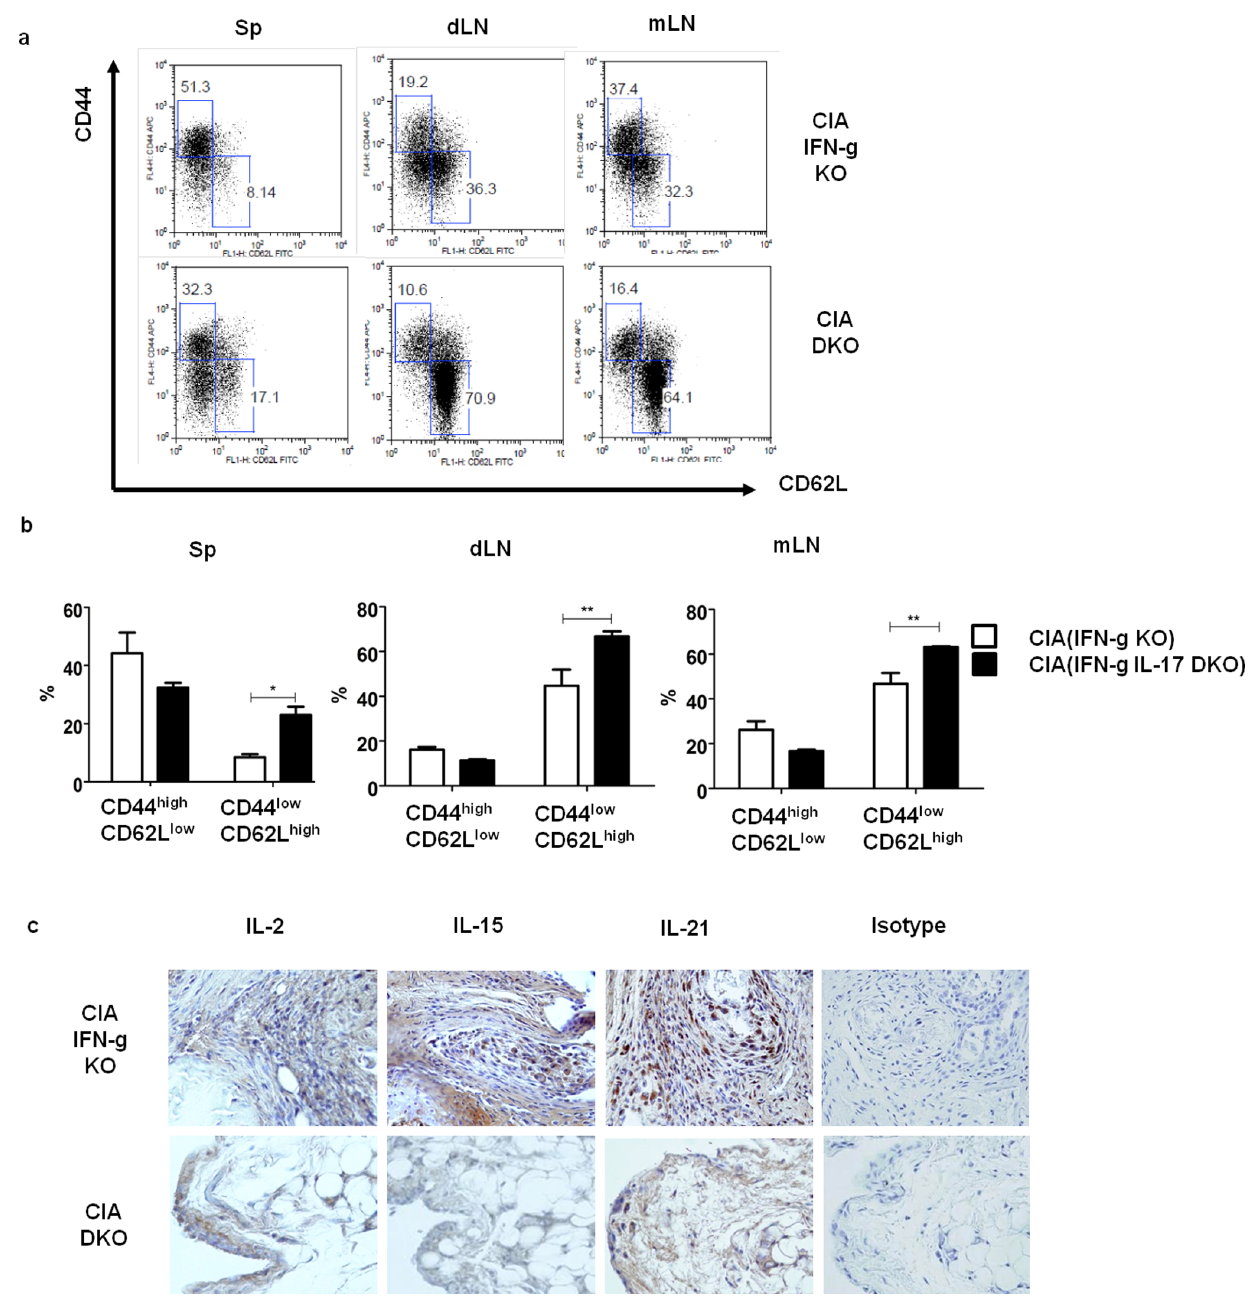
Figure 3. The proportion of naı¨ve T cells increased in IFN- c /IL-17 double knockout mice compared to that of IFN- c KO mice. Spleen, draining lymph nodes and mesenteric lymph node were removed at 5 th week after 1 st immunization, and prepared for single cell suspension. They were stained with PerCP - anti CD4 ab, APC - anti CD44 ab, and FITC - anti CD62L ab for flowcytometry. (a) Data represents one of three experiments. (b) CD4 + CD44 high CD62L low (memoryCD4 + T cells) T cell population was decreased in CIA (IFN- c IL-17 DKO) group while CD4 + CD44 low CD62L high (naı¨ve CD4 + T cells) population was increased. (c) IL-2, IL-15 and IL-21 were strongly expressed in the joint synovium of CIA (IFN- c KO). Original magnification, 200x. Mann-Whitney U test used (b). Values are presented as the mean 6 standard deviation of four independent experiments. *, p , 0.05, **, p , 0.005 ***, p , 0.001.